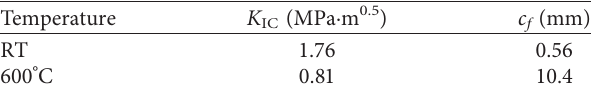
Table 5: The size effect law (SEL) parameters of granite.